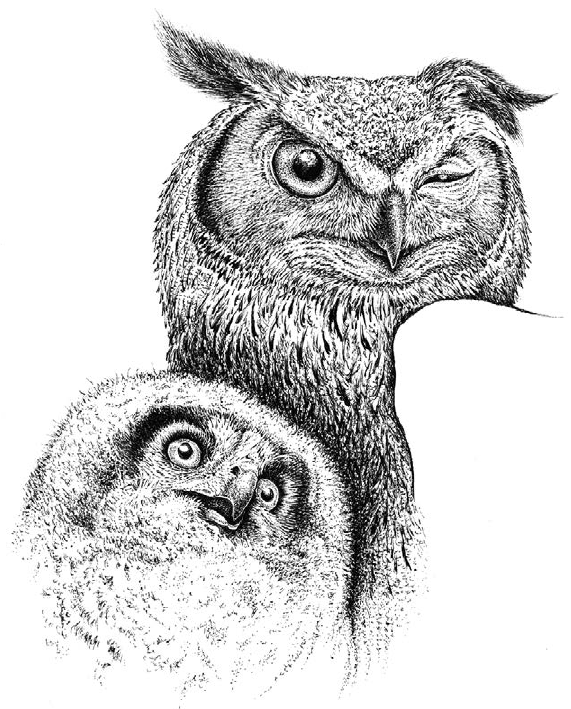
5. Indian Monitor Varanus bengalensis . Drawn using technical pen (Rotring .20).